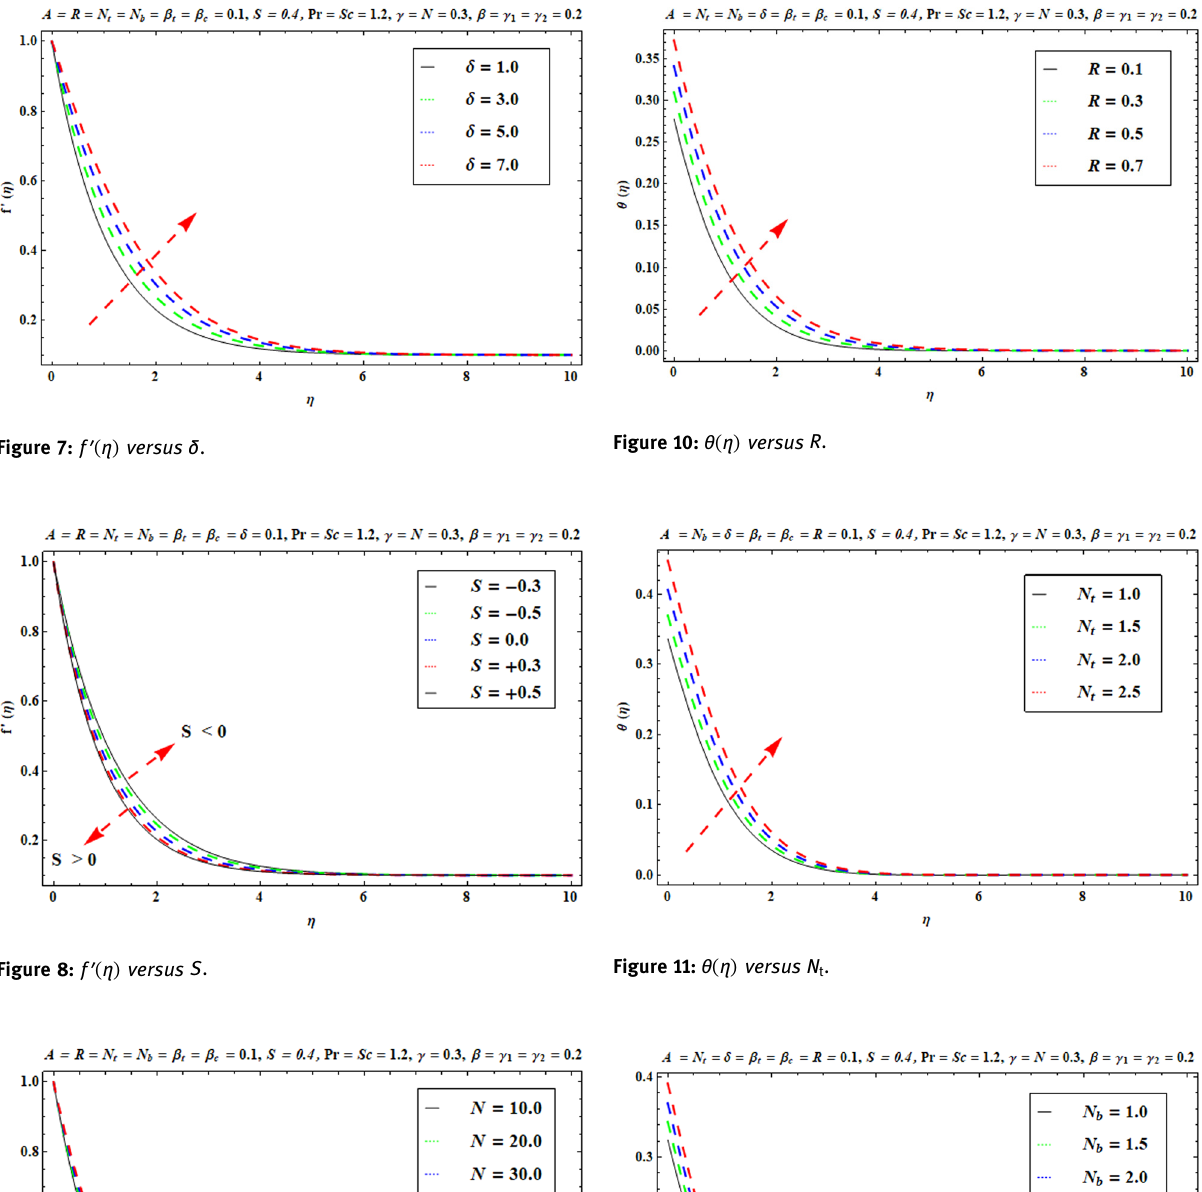
Figure 8: f η ′ ( ) versus S .